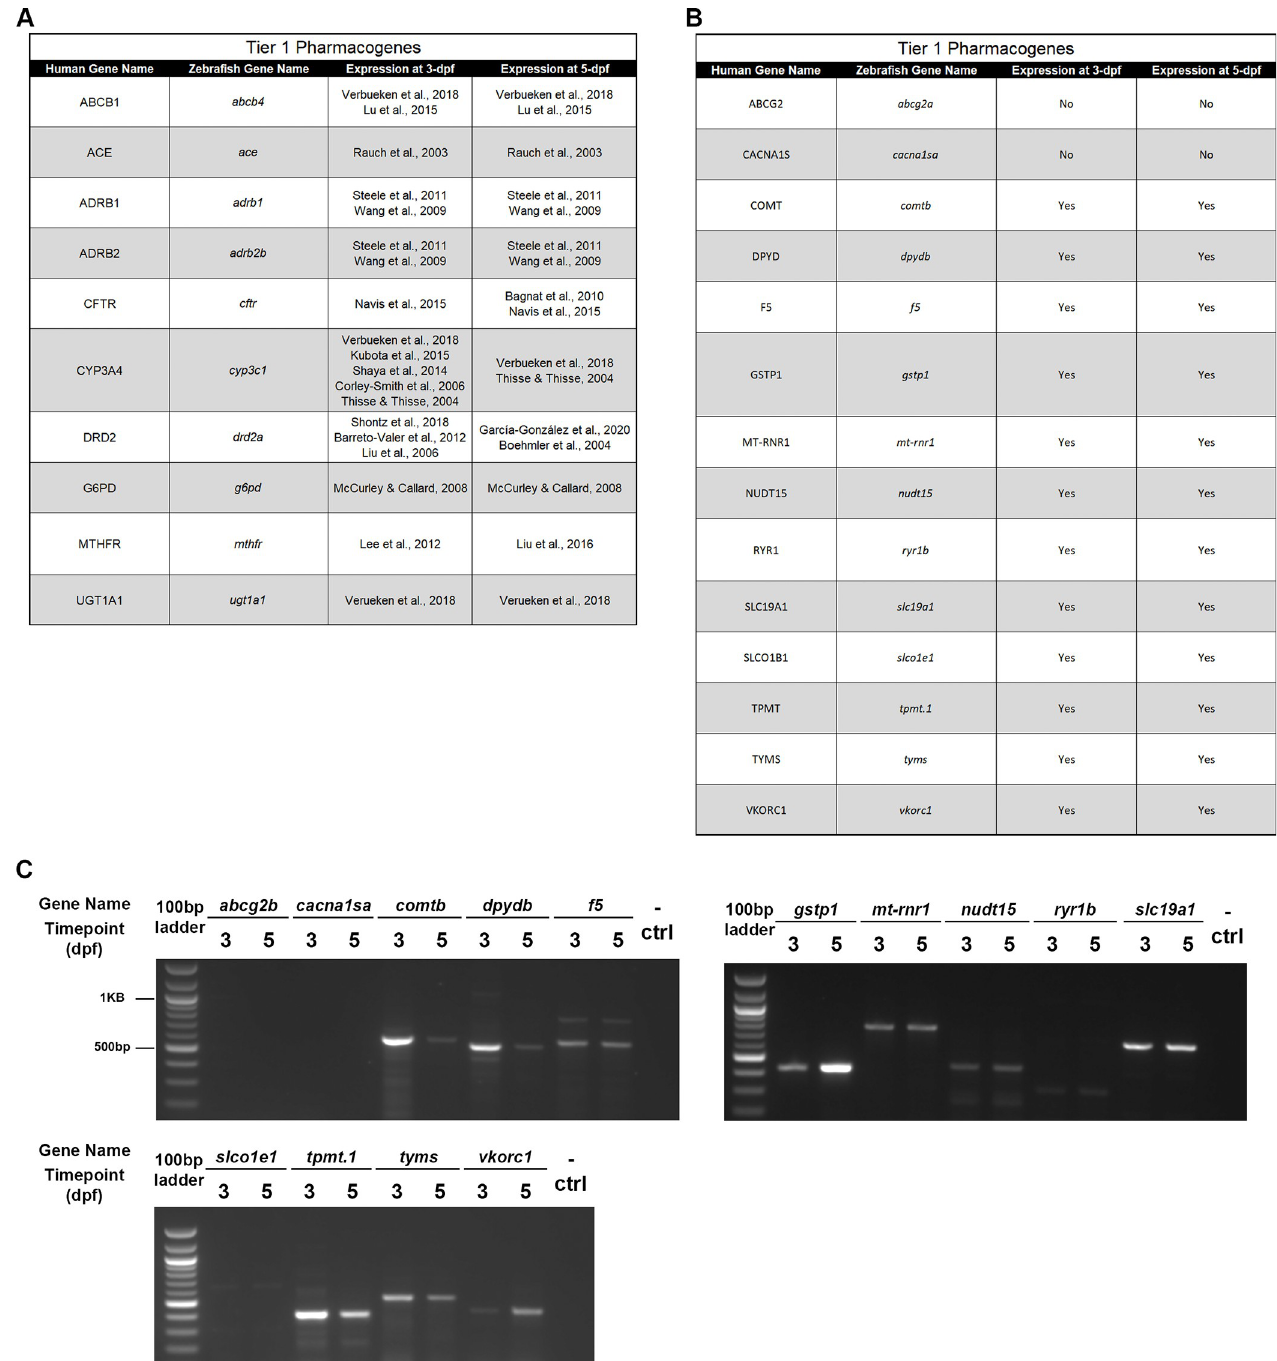
Fig 3. Zebrafish expression of Tier 1 pharmacogenes. A. Previously published literature housing information on expression of Tier 1 pharmacogenes in zebrafish. B. Tier 1 pharmacogene expression in zebrafish: “Yes” indicates expression was noted, “No” indicates no expression found. C. RT-PCR gel results for each Tier 1 zebrafish ortholog not previously identified in the literature. Gene name is listed at the top with the 3-days post fertilization (dpf) and 5-dpf included under the respective gene in alphabetical order. Each gel had a 100-base pair (bp) ladder (left) and a negative control (- ctrl, left).